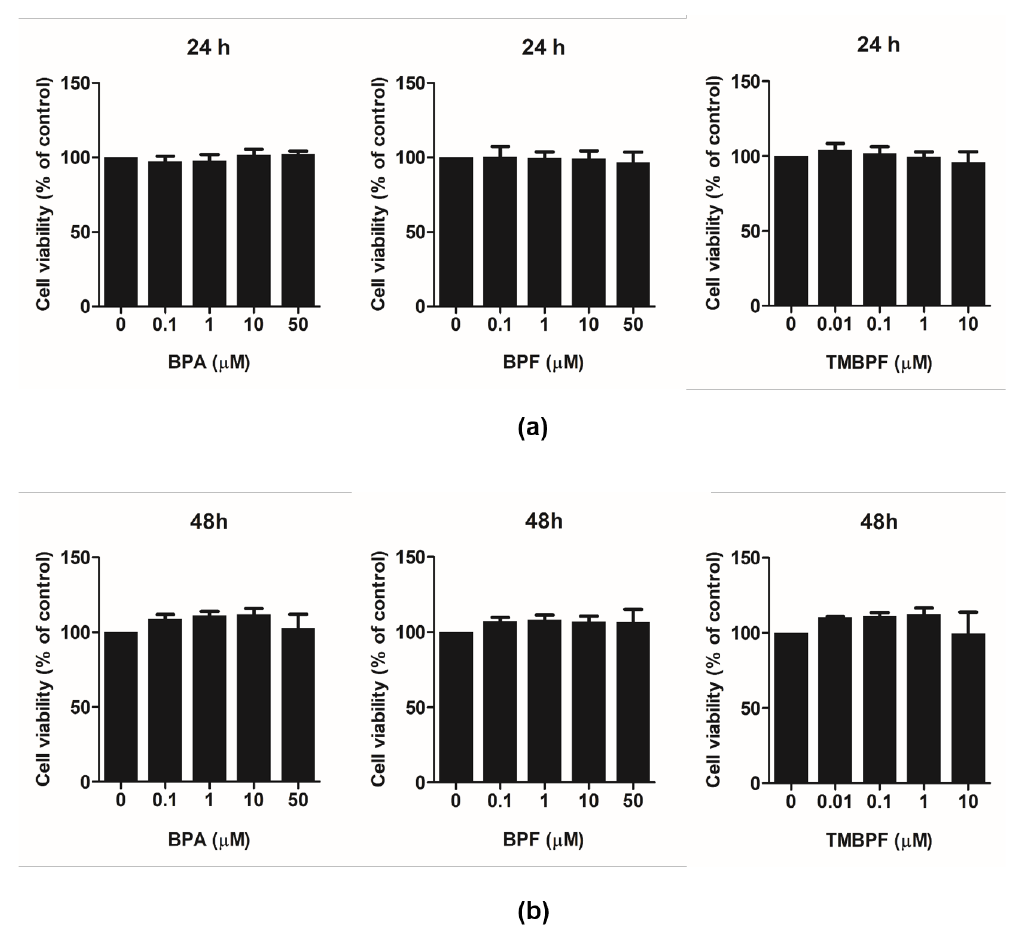
Figure 1. Chemical structures of bisphenol A (BPA) and its substitutes, bisphenol F (BPF) and tet- ramethyl bisphenol F (TMBPF).